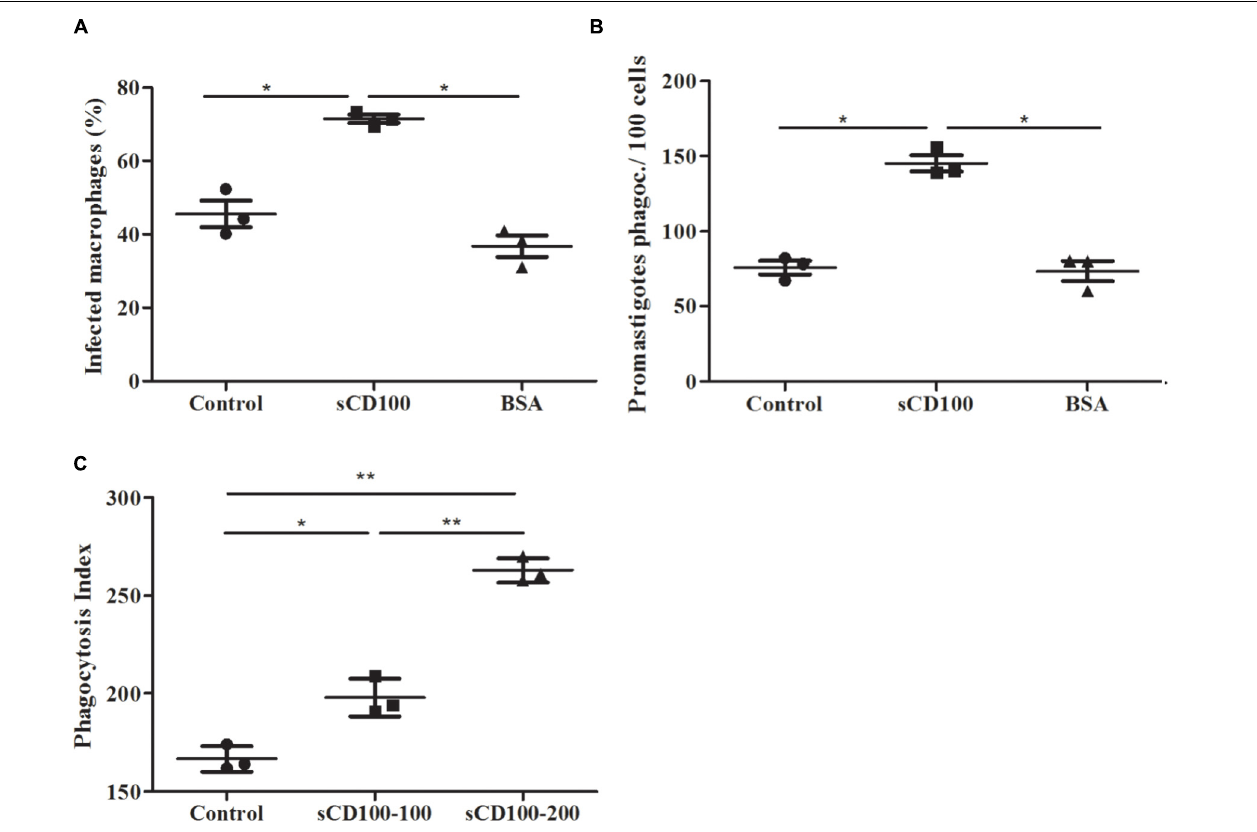
FIGURE 6 | Effect of sCD100 on phagocytosis of Leishmania and zymosan by peritoneal macrophages from BALB/c. (A) Percentage of infected macrophages and (B) promastigotes phagocytosed by 100 macrophages in the continuous presence of 100 ng/mL sCD100 or BSA or with no stimulus (control), analyzed by immunofluorescence. Data represent means and standard deviations of three independent experiments. (C) Phagocytosis index of zymosan using 1 particle per macrophage for 1 h in the continuous presence of 100 or 200 ng/mL sCD100 or with no stimulus (control). Results of a representative experiment out of three with similar values. Statistical analysis was performed by ANOVA followed by Tukey’s post-test, and significant differences are labeled as ∗ p ≤